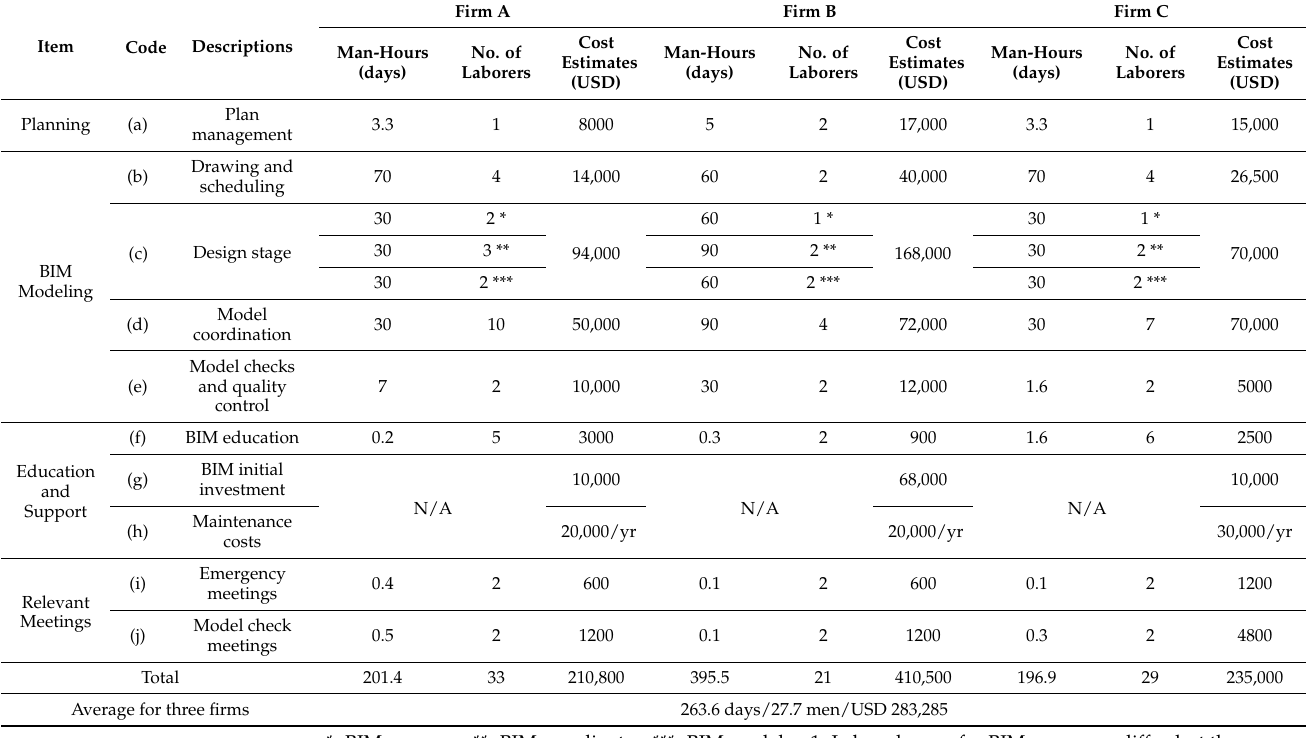
Table 4. Man-hours and the number of laborers for BIM projects.